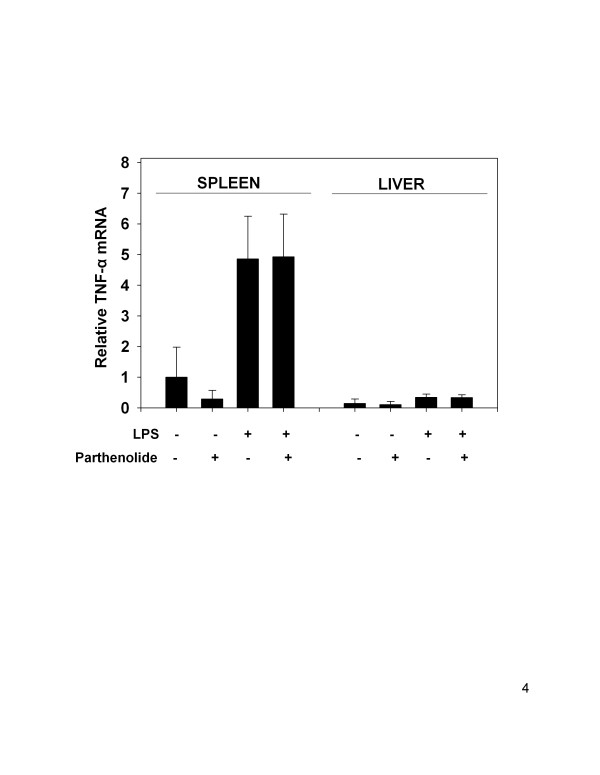
TNF-α mRNA expression levels in spleen and liver following parthenolide and LPS co-treatment. Mice were treated and analyzed for TNF-α mRNA described in Fig. 2 legend. TNF-α mRNA levels were normalized using 18S rRNA and related to spleen control values. Data are mean ± SEM (n = 16, controls n = 4), and is a combination of 4 separate experiments.